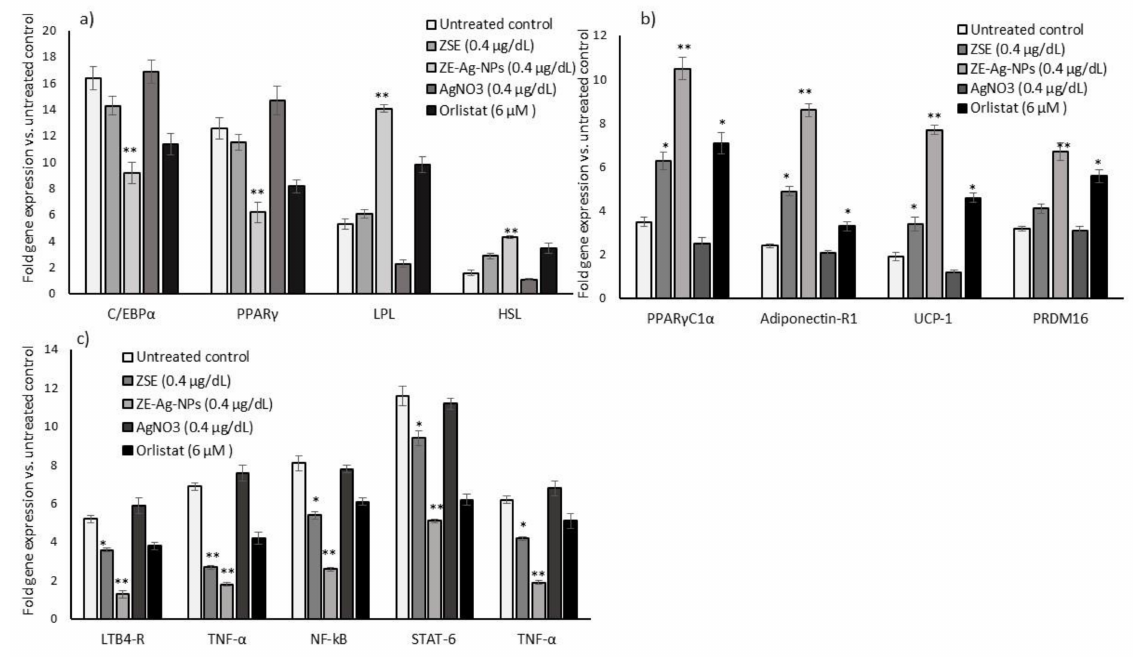
Figure 5. Effect of ZSE, AgNO 3 , ZS-Ag-NPs, and orlistat on adipogenesis ( a ), mitochondrial fatty acid oxidation, and thermogenesis ( b ) and adipokines responsible for metabolic inflammation ( c ) related gene expression levels in maturing adipocytes after 14 days. Each value is a mean ± SD ( n = 6). * significant at p ≤ 0.05 and ** highly significant at p ≤ 0.001, by comparison with the vehicle control.